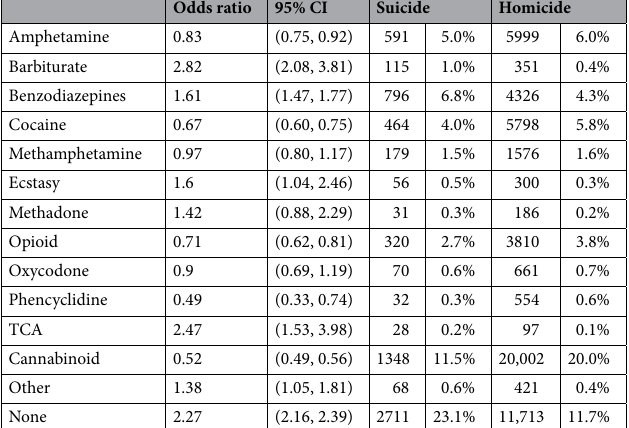
Table 4. Drugs observed in homicide and suicide groups. The odds ratio (OR) and its 95% confidence interval (CI) are shown, along with the number and percent of homicides and suicides who had a drug in their system. TCA tricyclic antidepressants.